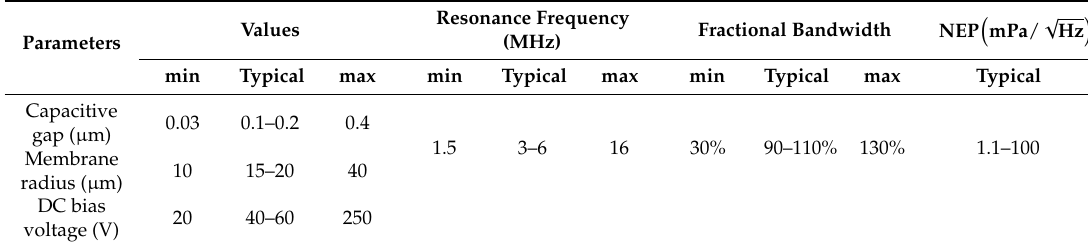
Table 6. Overview of typical parameters of cMUTs applied in PAI